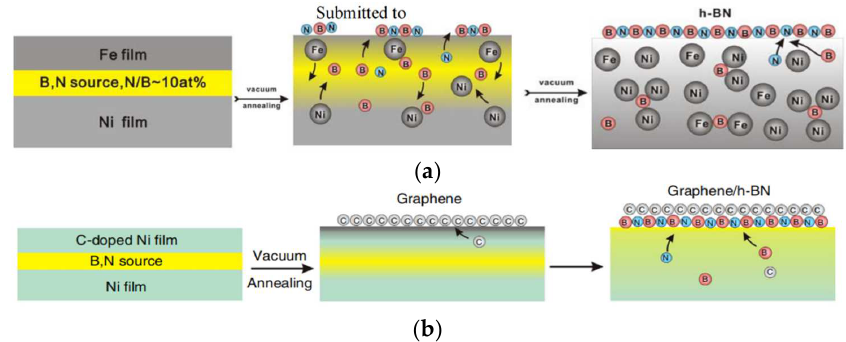
Figure 23. Hexagonal boron nitride thin films were prepared with the co-segregation method [67]. ( a ) the system of Fe-B/N-Ni; ( b ) the system of